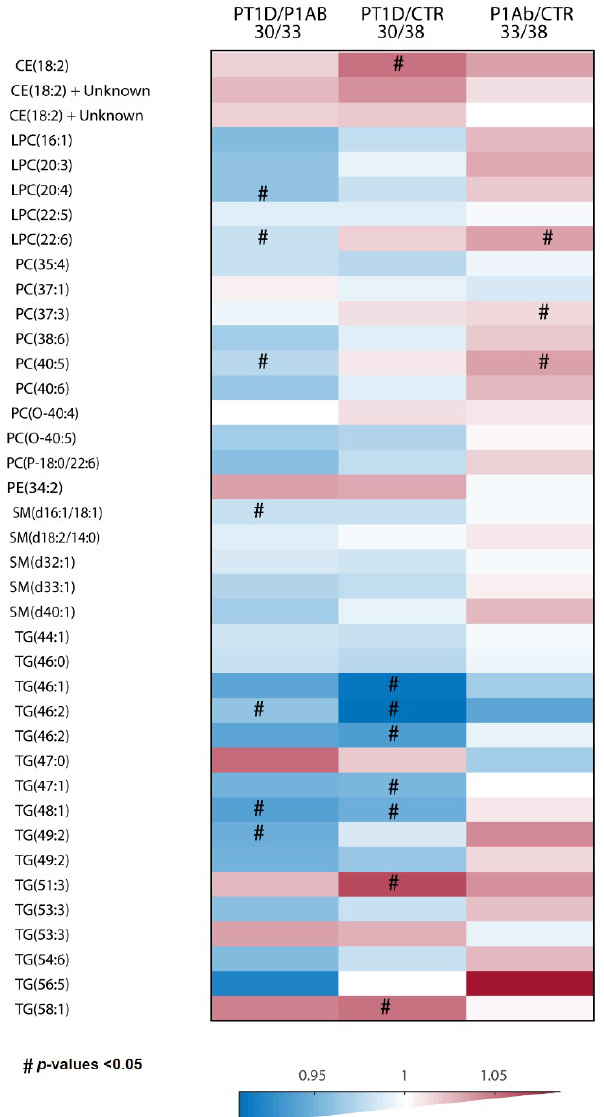
Figure 1. The differences in global cord plasma lipidome between the three study groups. Heat map showing 40 lipid species representative of lipid classes that change between PT1D, P1Ab and CTR. Differences in lipid concentrations were calculated by dividing the mean concentration in PT1D by the mean concentrations in P1Ab and CTR. # represents the p -values <0.05. Abbreviations: cholesterol ester (CE), phosphatidylcholine (PC), phosphatidylethanolamine (PE), sphingomyelin (SM), and triacylglycerol (TG), lysophosphatidylcholines (LPC).